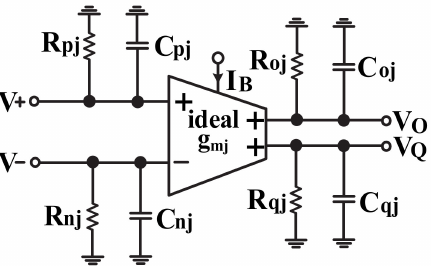
Figure 4. The non-ideal OTA with its parasitic resistors and capacitors.